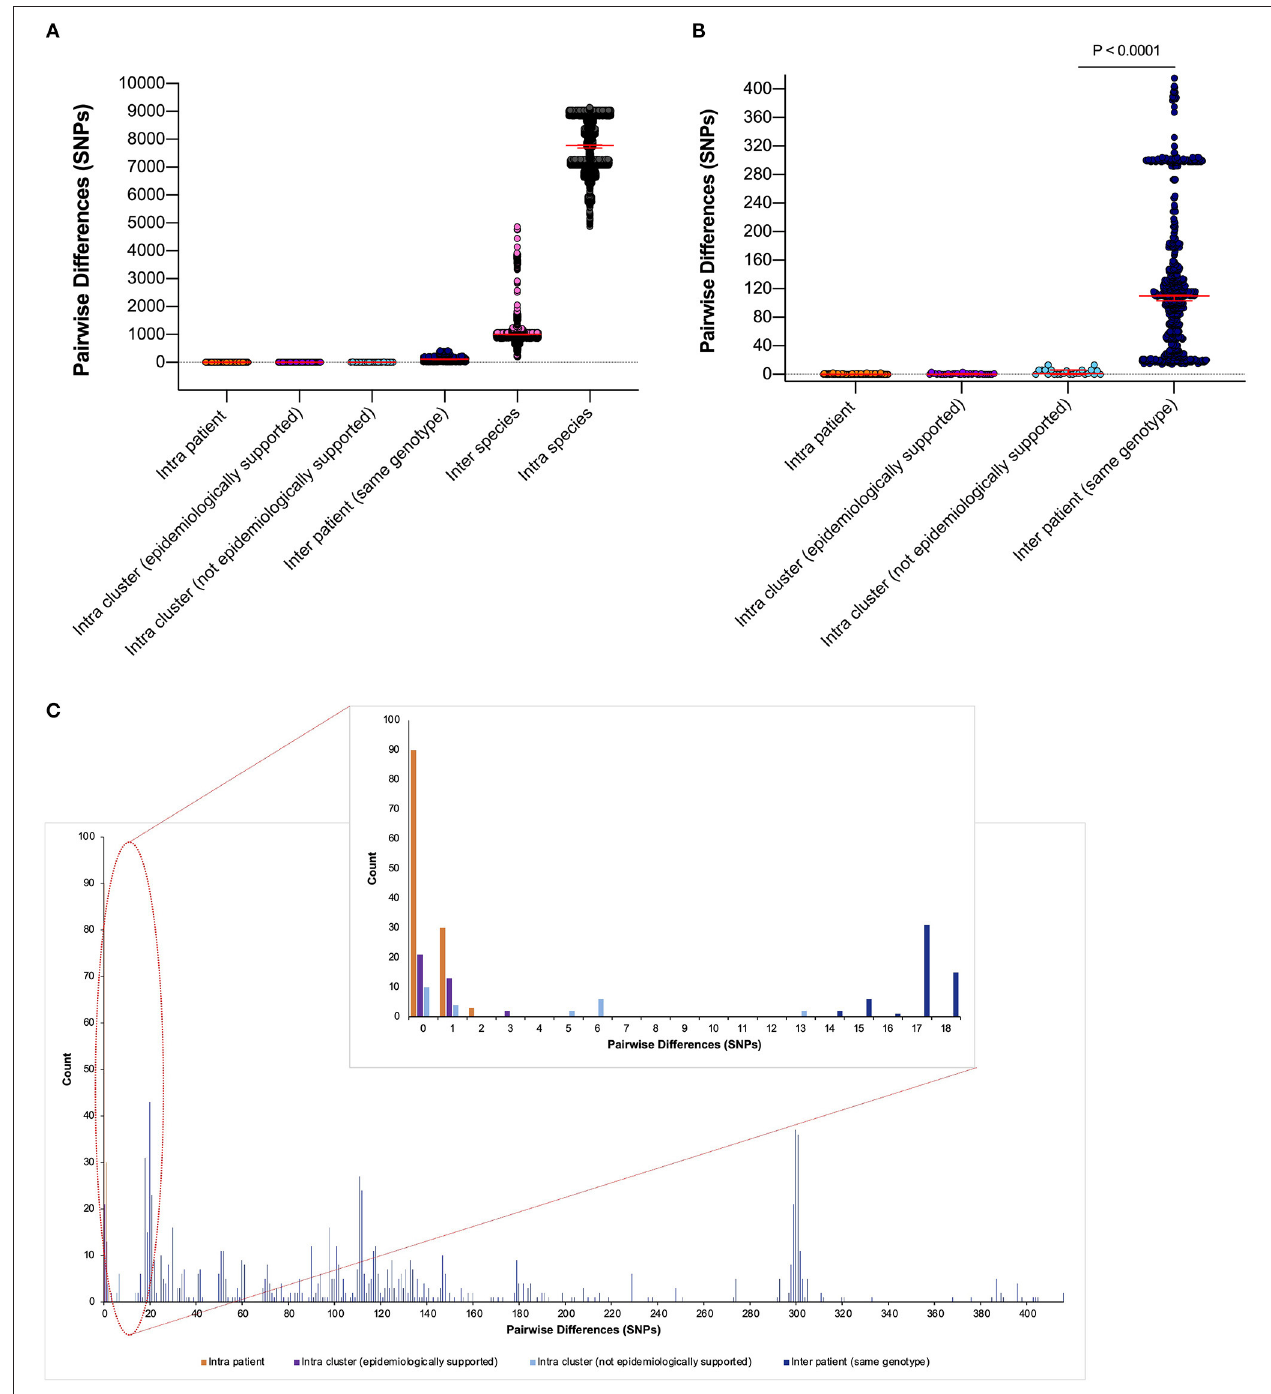
FIGURE 4 | Pairwise differences equating to single-nucleotide polymorphisms (SNPs) between clinical samples included in this study. (A) Pairwise differences were plotted by the following categories: “intra patient,” differences between samples taken from the same patient; “intra cluster (epidemiologically supported),” differences between samples from different patients within a monophyletic cluster that are temporally linked (HAdV PCR positive whilst admitted to same/linked ward) by the admission data; “intra cluster (not epidemiologically supported),” differences between samples from different patients within a monophyletic cluster that are not linked temporally by the admission data; “inter patient (same genotype),” differences between samples from different patients within the same genotype; “inter species,” differences between samples from different patients within the same species but different genotypes and “intra species,” differences between samples from different patients between species. Median values with 95% CIs are superimposed and plotted in red. (B) Differences between the first four categories to aid visualization. (C) Highlighted precise count of pairwise differences found within the first four categories.